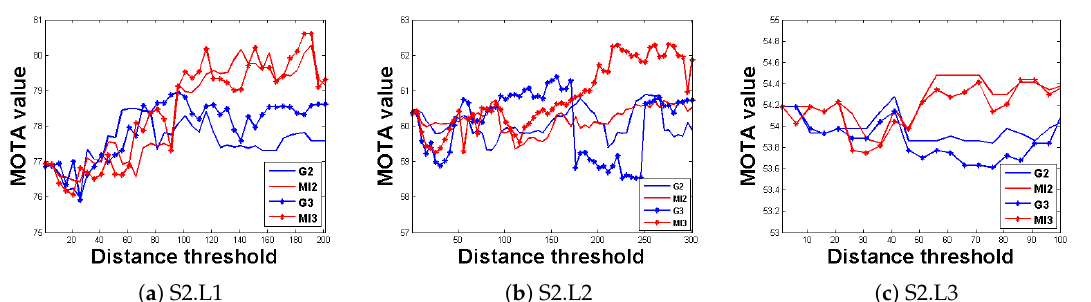
Figure 8. Evaluation results of tracklet coupling generation. The horizontal axis represents the distance threshold, whereas the vertical axis represents the tracking accuracy. The solid line indicates that the experiment is conducted using data from two views, while the asterisk line indicates that the experiment is conducted using data from three views. Blue represents the Gaussian distance metric and red represents the coupling method based on image mutual